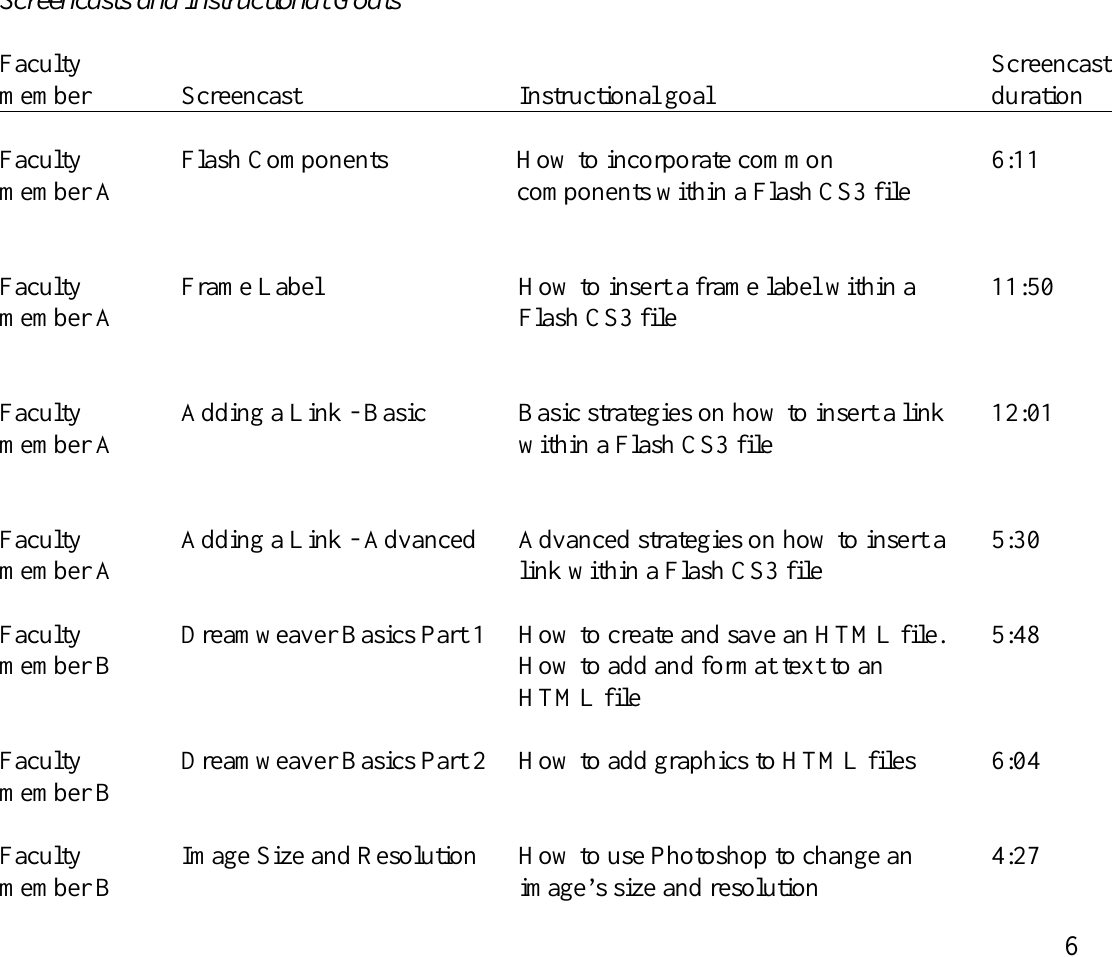
Screencasts and Instructional